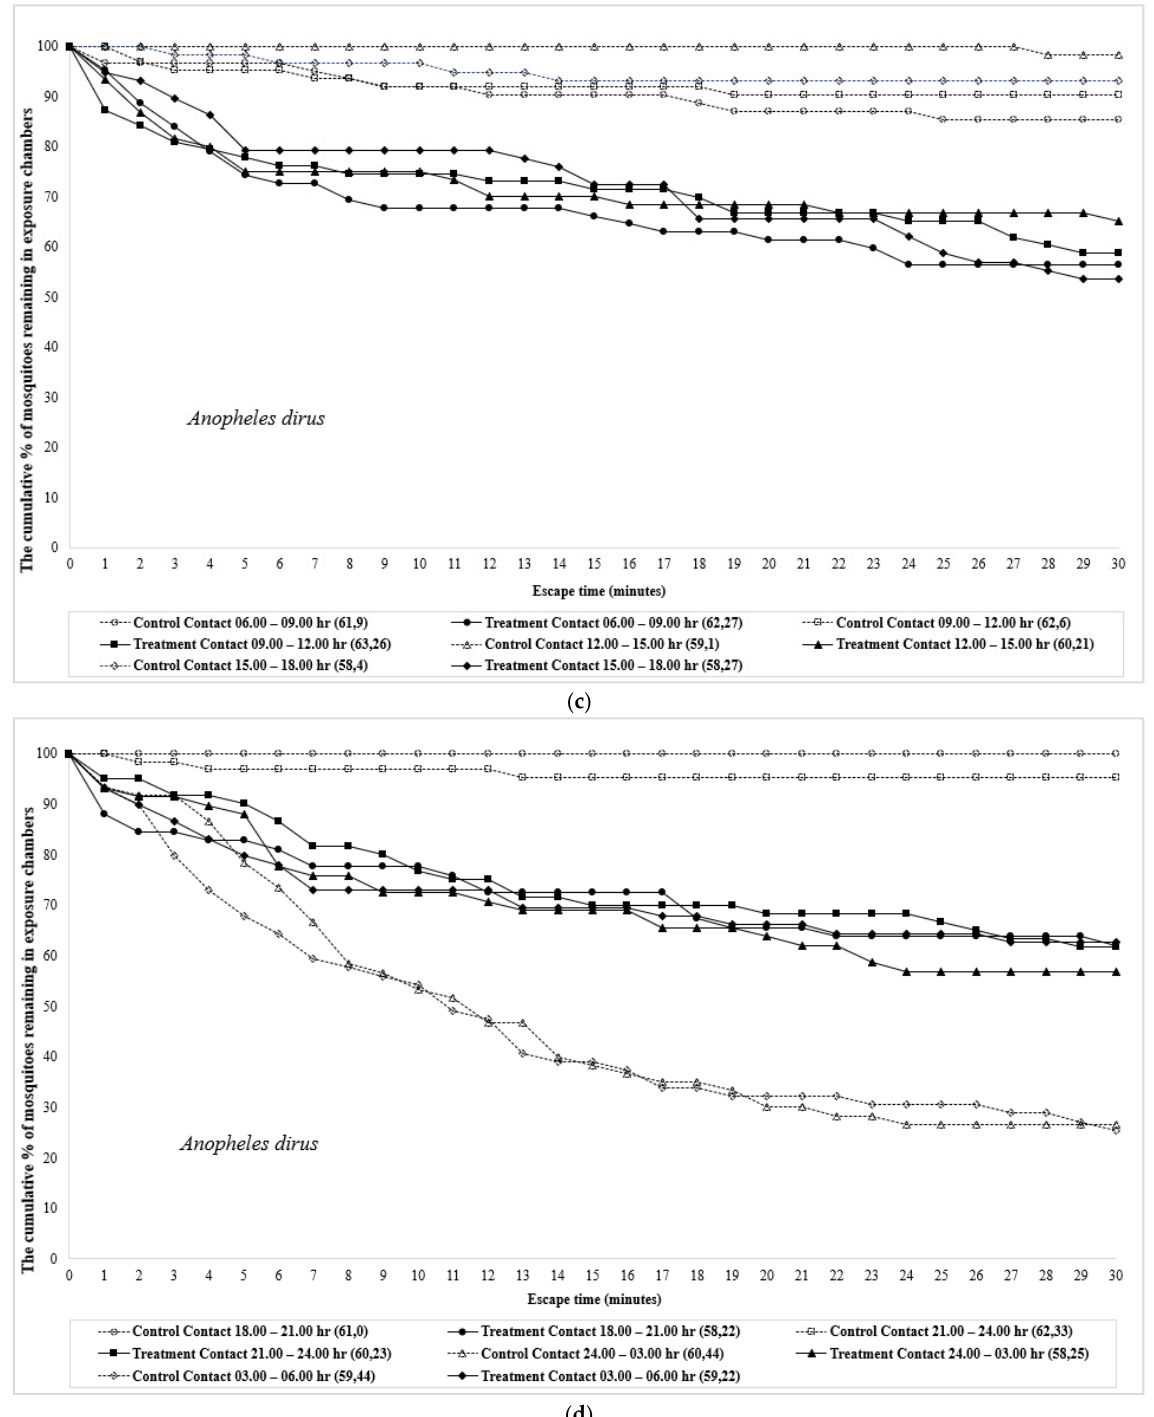
Figure 2. Kaplan–Meier survival curves showing escape responses by ( a ) Anopheles minimus -day; ( b ) Anopheles minimus - night; ( c ) Anopheles dirus -day; and ( d ) Anopheles dirus -night between different time intervals in contact trials when exposed to DEET. The number of individuals subjected to test (first number) and those escaped (second number) are given in parentheses.